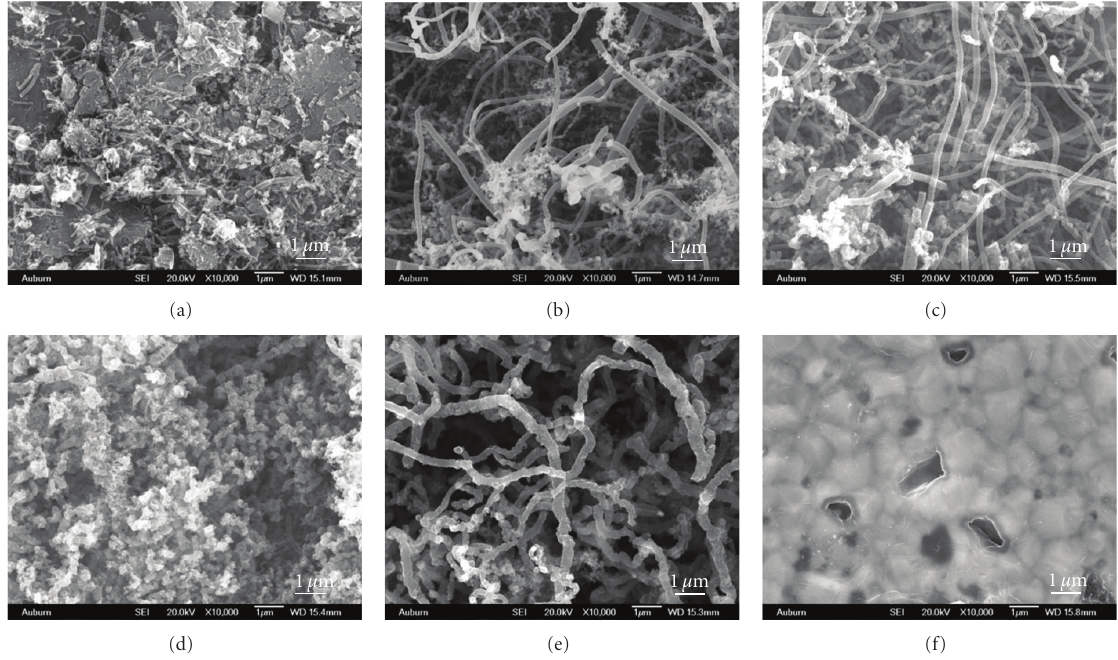
Figure 7: CNF growth in 98% H 2 (2% C 2 H 2 ). Temperature: (a) 470 ◦ C, (b) 520 ◦ C, (c) 570 ◦ C, (d) 620 ◦ C, (e) 670 ◦ C, and (f) 720 ◦ C. Sample faceted at 815 ◦ C (Table 1 (Phase